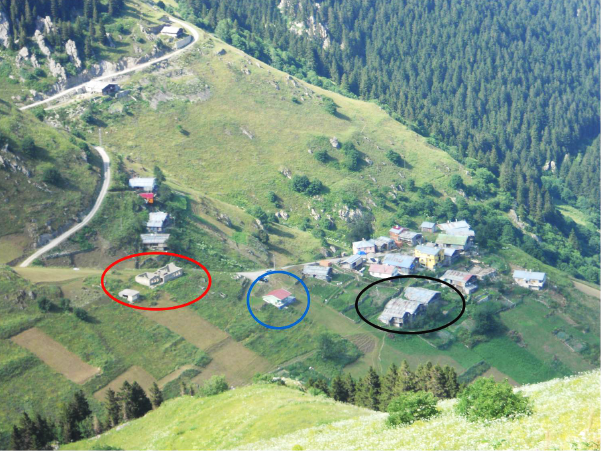
Fig. 5. Damaged school building (red ellipse) and houses (black ellipse) due to the 1981 avalanche; house indicated in blue circle constructed in